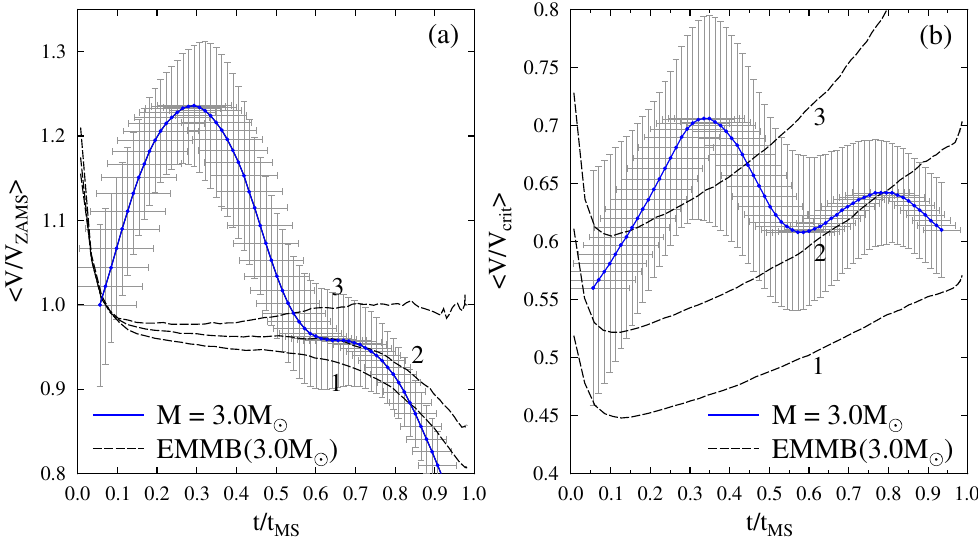
Figure 34. Comparison of the observed evolution of equatorial velocity ratios in the MS life- time span for stars with M = 3 M (cid:12) inferred from observations with theoretical ones calculated by Ekström et al. [541] (EMMB) for different V / V crit on the ZAMS. ( a ) The evolution of V / V ZAMS ratios; ( b ) evolution of V / V crit ratios. Curves 1, 2 and 3 refer to the different values of V ZAMS , which corre- spond to the values of V in the initial ratios V / V crit of panel b . Adapted from Zorec and Royer [289]. Table 2. Synopsis of the average evolution of equatorial velocities of 2.5 M (cid:12) and 3.0 M (cid:12)